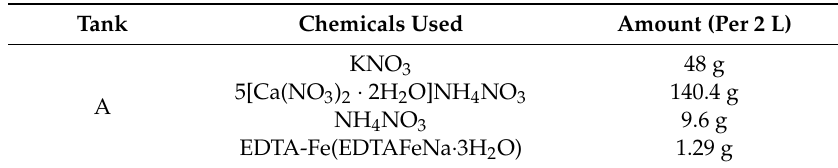
Table 1. Compositions of chemical compounds used for preparing 200 times concentrated solutions for hydroponic cultivation of paprika